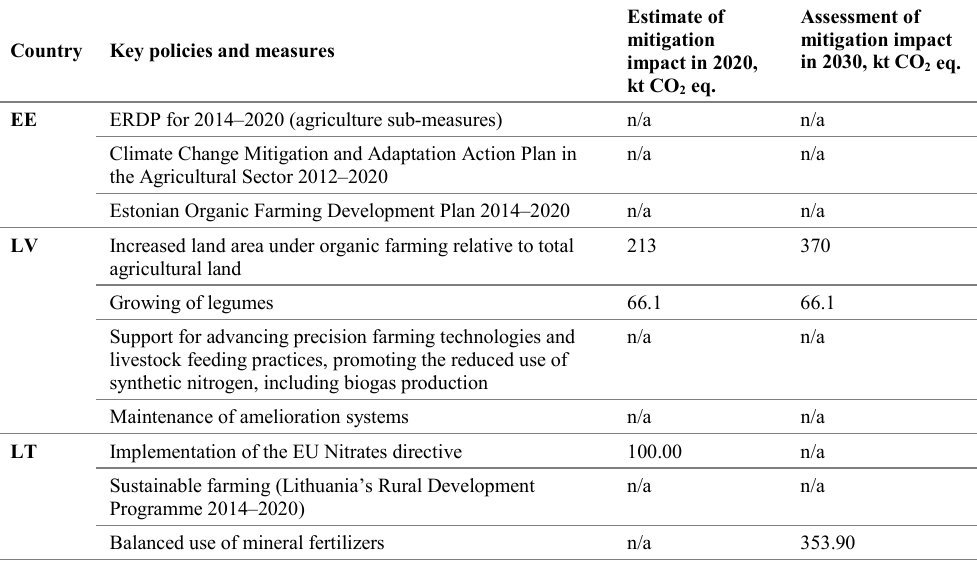
in 2030, kt CO 2